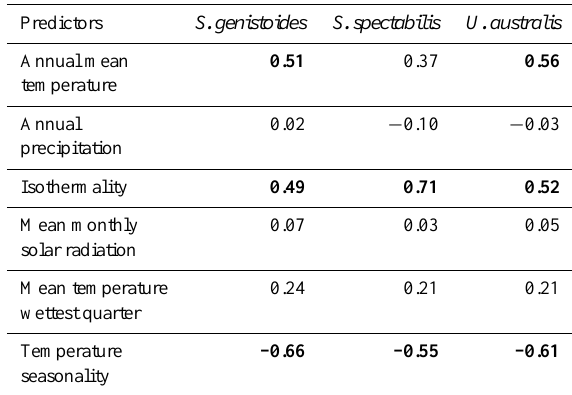
Table 2. Marginality values for the climatic predictors used in the three keystone species analyses, according to an Ecological Niche Factor Analysis (ENFA). Most relevant variables (values beyond |0.4|) in bold.